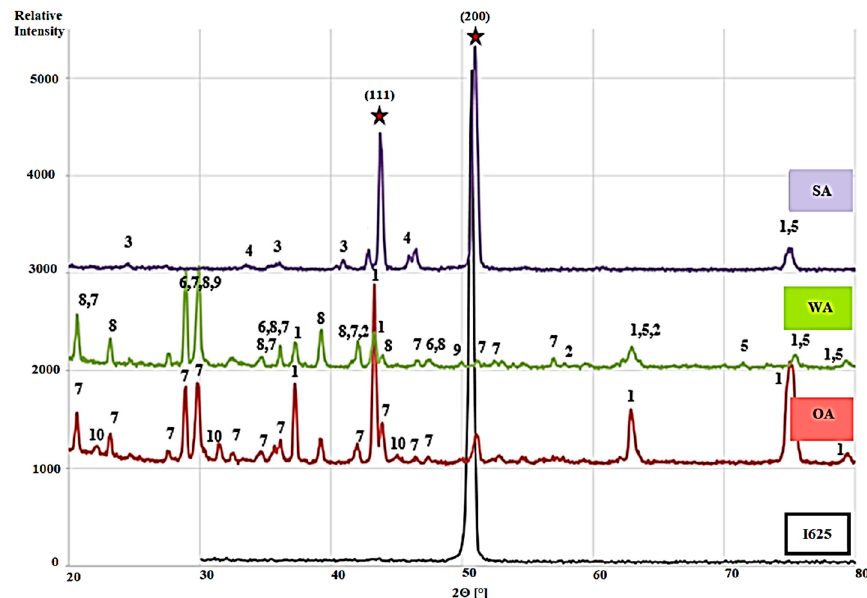
Figure 2. The XRD phase analysis of pure Inconel 625 (I625) and after exposure to the three ashes (OA, WA, and SA) with the identified mineral phases: 1—NiO, 2—Fe 3 O 4 , 3—Fe 2 O 3 , 4—Cr 2 O 3 , 5—NbO, 6—CaCO 3 , 7—K 2 CrO 4 , 8—K 2 MnO 4 , 9—K 2 MoO 4 , 10—KNbO 3 , ★ —the signal coming from the substrate, austenitic matrix plane 2 θ = 43.1° (111), 2 θ = 50.3° (200).